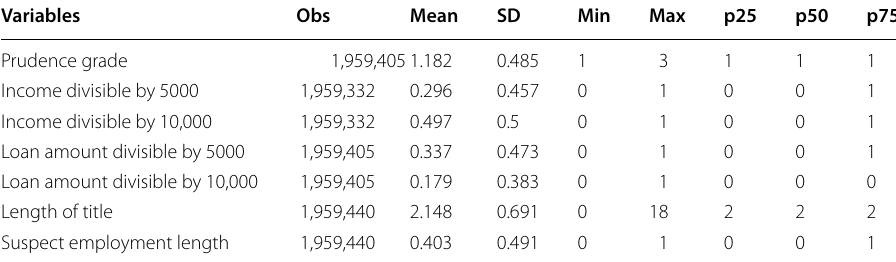
Table 3 Summary statistics of misreporting